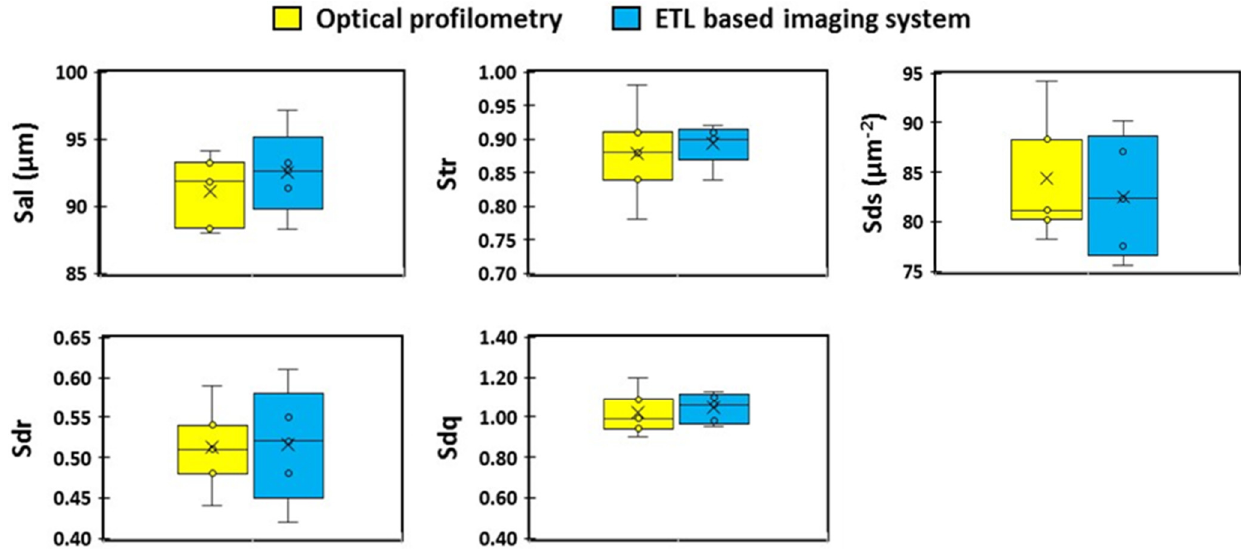
Figure 9. Spatial and hybrid parameters of 3D surface texture analysis. Sal: surface autocorrelation length; Str: surface aspect ratio; Sds: surface density summits; Sdr: interfacial area ratio; and Sdq: surface root mean square.